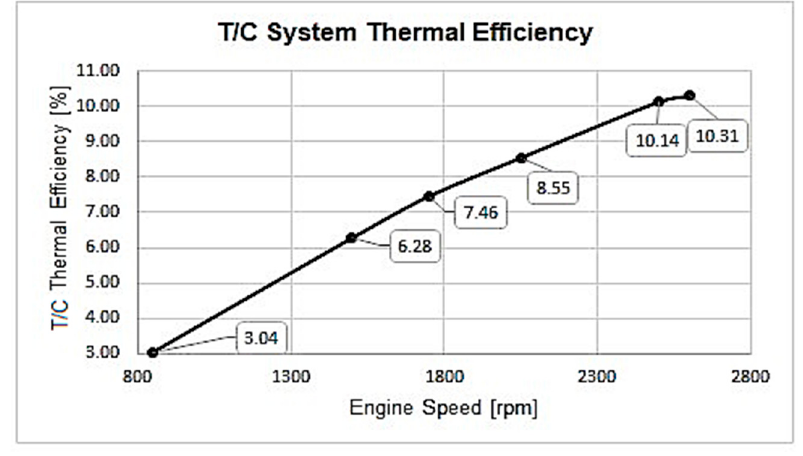
Figure 20. T / C system thermal e ffi Figure 20. T/C system thermal efficiency. Figure 20. T/C system thermal efficiency.